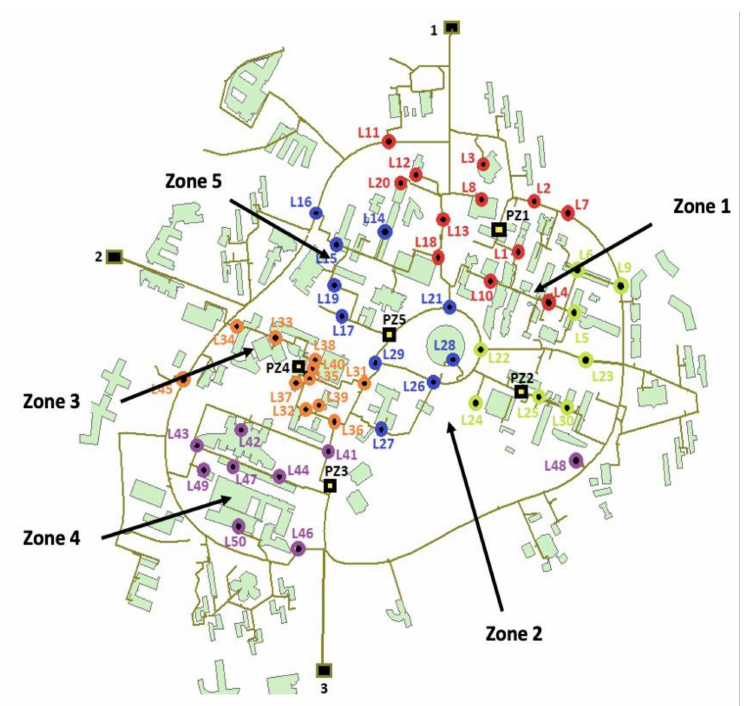
Figure 2. EPANET model of the water network ono the scientific campus (45 pipes, 33 junctions). L n designates the position of leak n , Pzm designates the position of the pressure sensor number m. The black squares indicate the supply section. Table 2. Leakage scenarios were used for the generation of data (leak nodes are given in Figure 2).